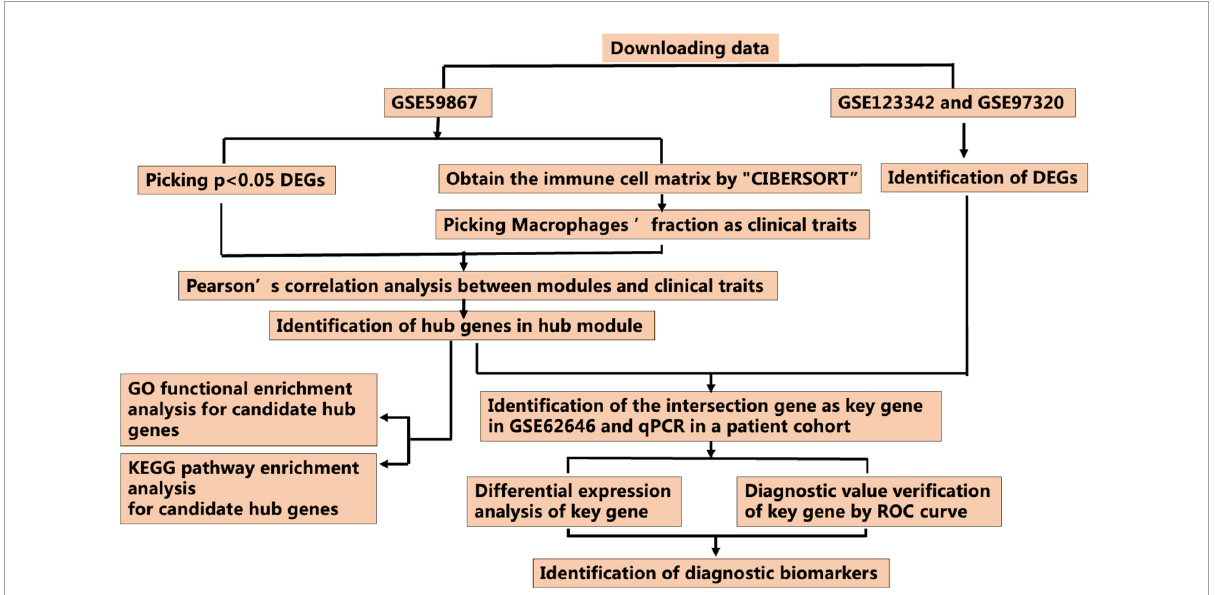
FIGURE1 Workflow for identification of the novel M2 macrophage-related biomarkers through the CIBERSORT and weighted gene correlation network analysis (WGCNA) algorithms (DEGs, differentially expressed genes; ROC curve, receiver operating characteristic curve).